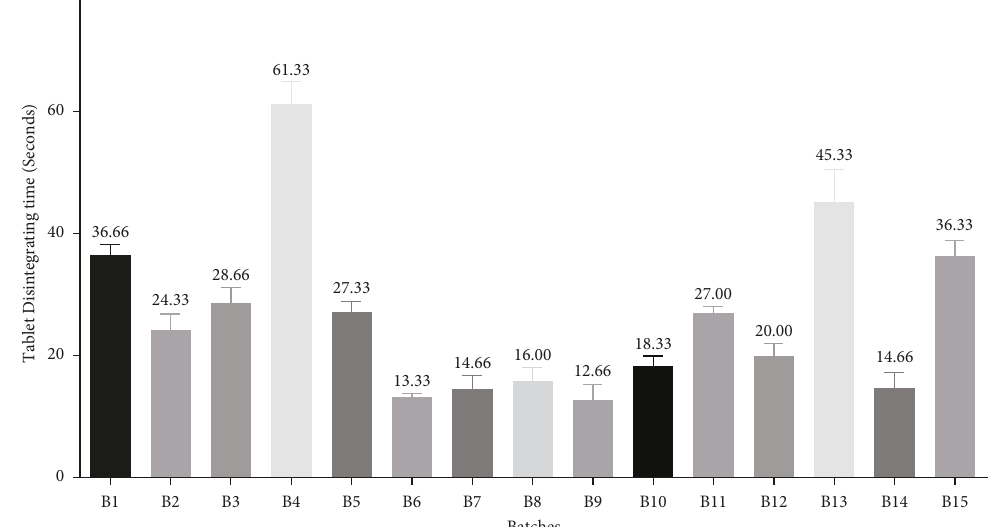
Batches Figure 4: Bar diagram for the measurement of in vitro disintegration time (in seconds) for different